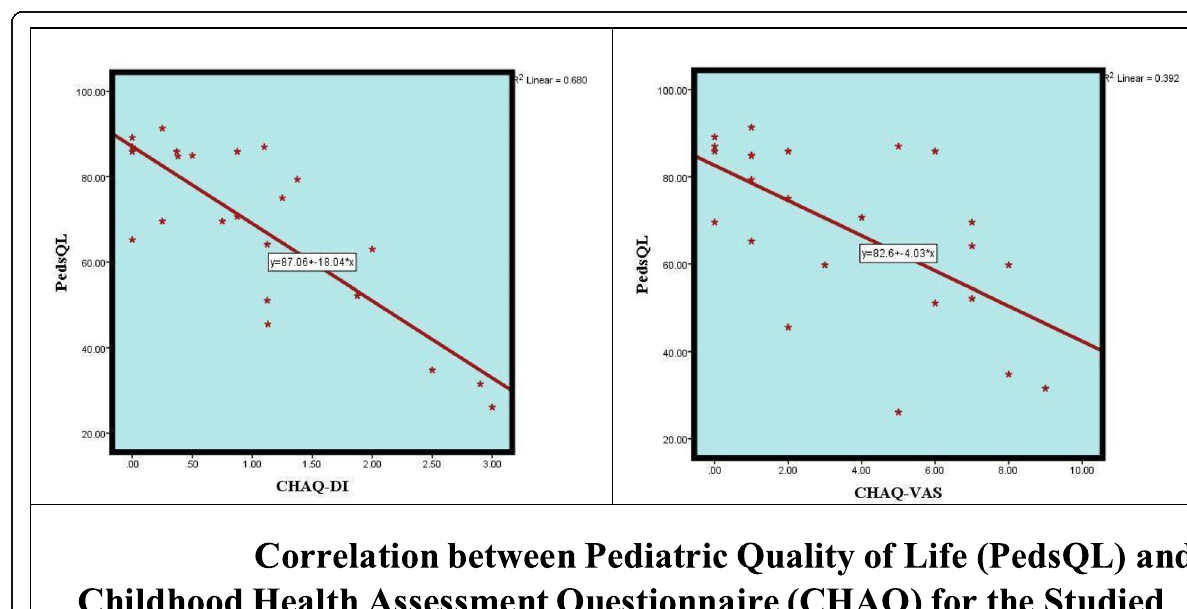
Fig. 1 Correlation between Pediatric Quality of Life (PedsQL) and Childhood Health Assessment Questionnaire (CHAQ) for the Studied JIA